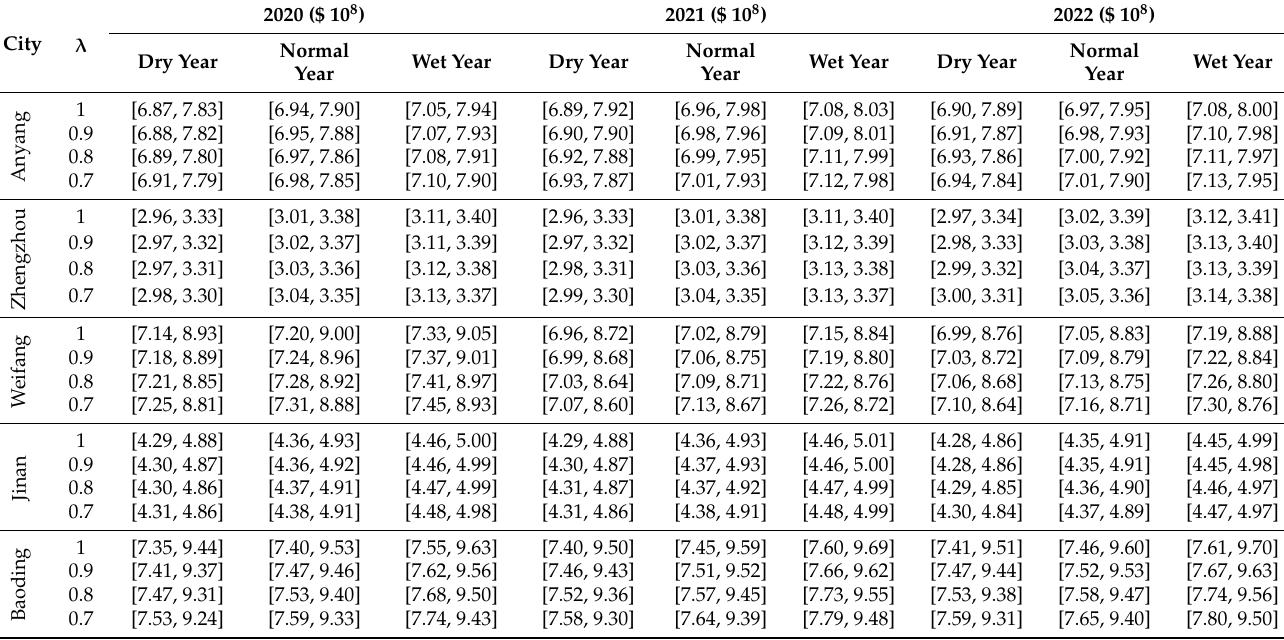
Table 11. Interval parameters of production value of winter wheat in five cities under different possibilities and